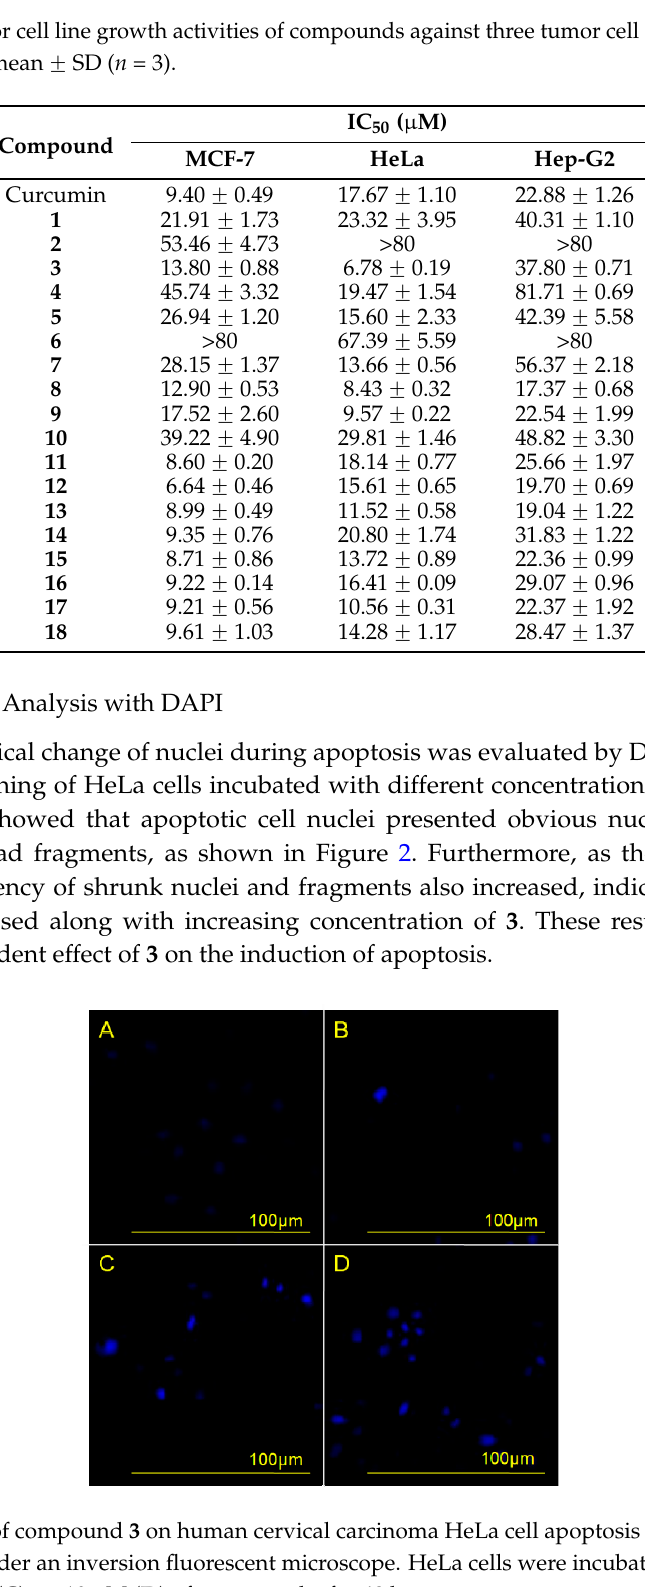
Table 1. Antitumor cell line growth activities of compounds against three tumor cell lines in vitro. Data are expressed as mean ± SD ( n = 3).